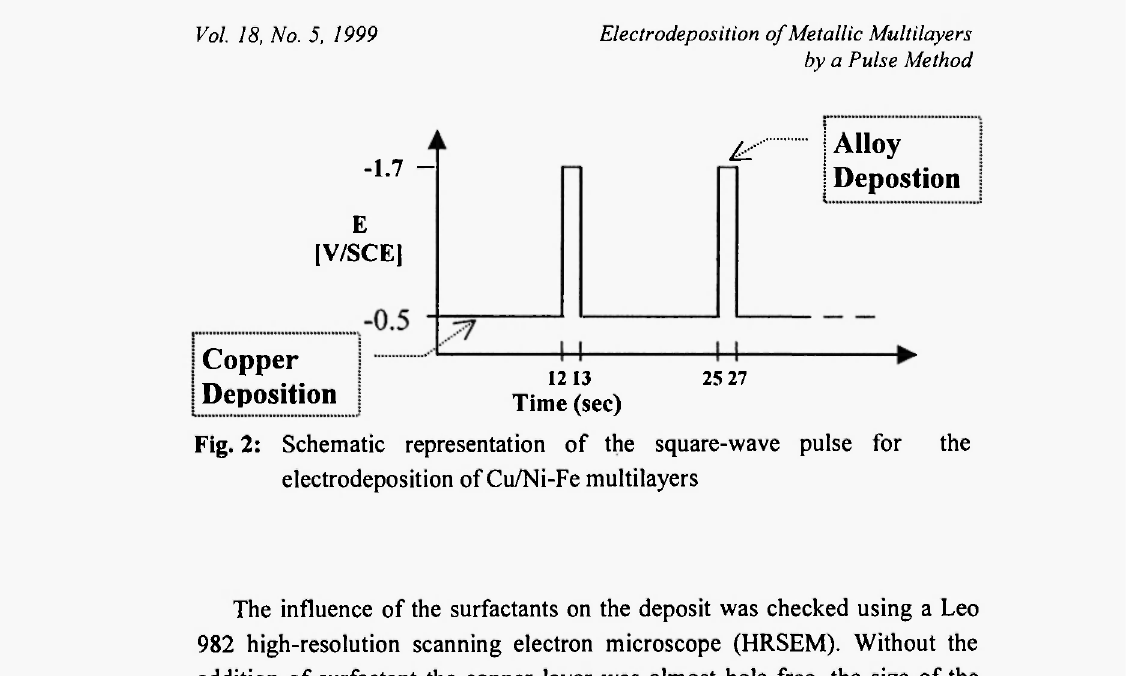
Fig. 2: Schematic representation of the square-wave pulse for the electrodeposition of Cu/Ni-Fe multilayers